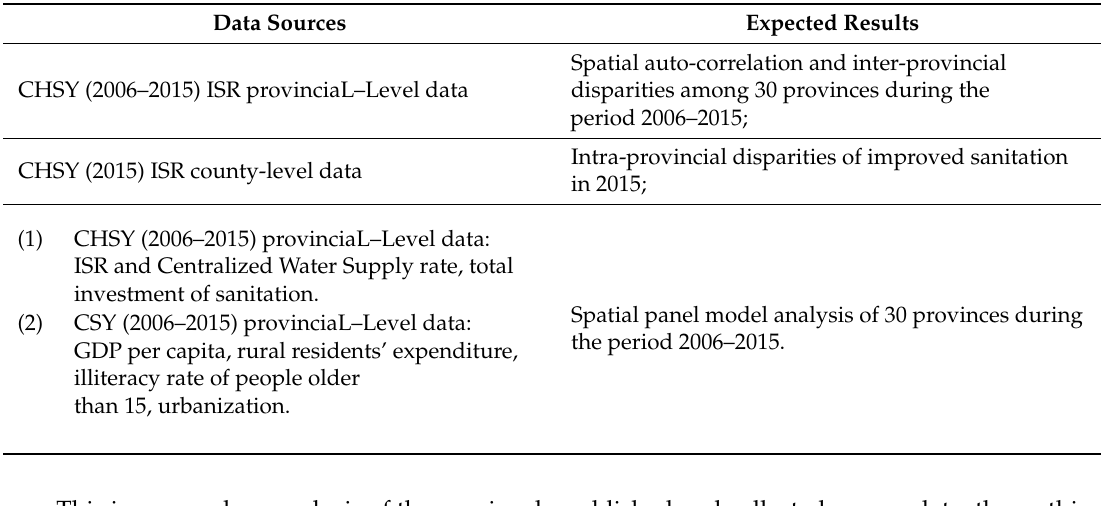
Table 1. Data sources and expected results (CHSY: China Health Statistical Yearbook; ISR: improved sanitation rate; CSY: China Statistical